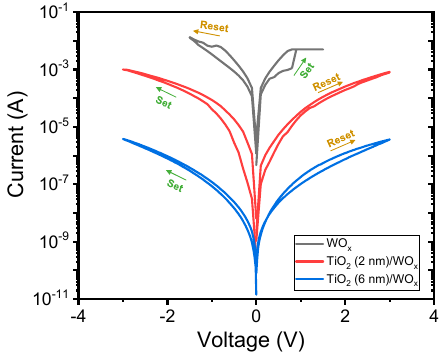
Figure 2. Typical I – V characteristics of three devices (TiN/WO x /Pt device, TiN/TiO 2 (2 nm)/WO x /Pt device, TiN/TiO 2 (6 nm)/WO x /Pt devices).